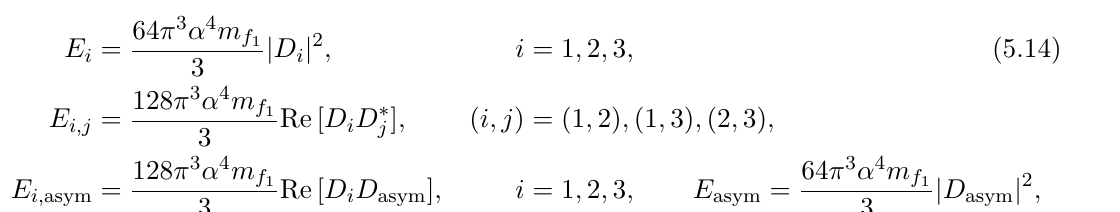
√ s m = 1 . 3 GeV ( q 2 ) ρ 0 ( q 2 ) ( right ), equation (3.13), together with the central ρ 0 × 10 − 9 [89] ( red − 2 . 7